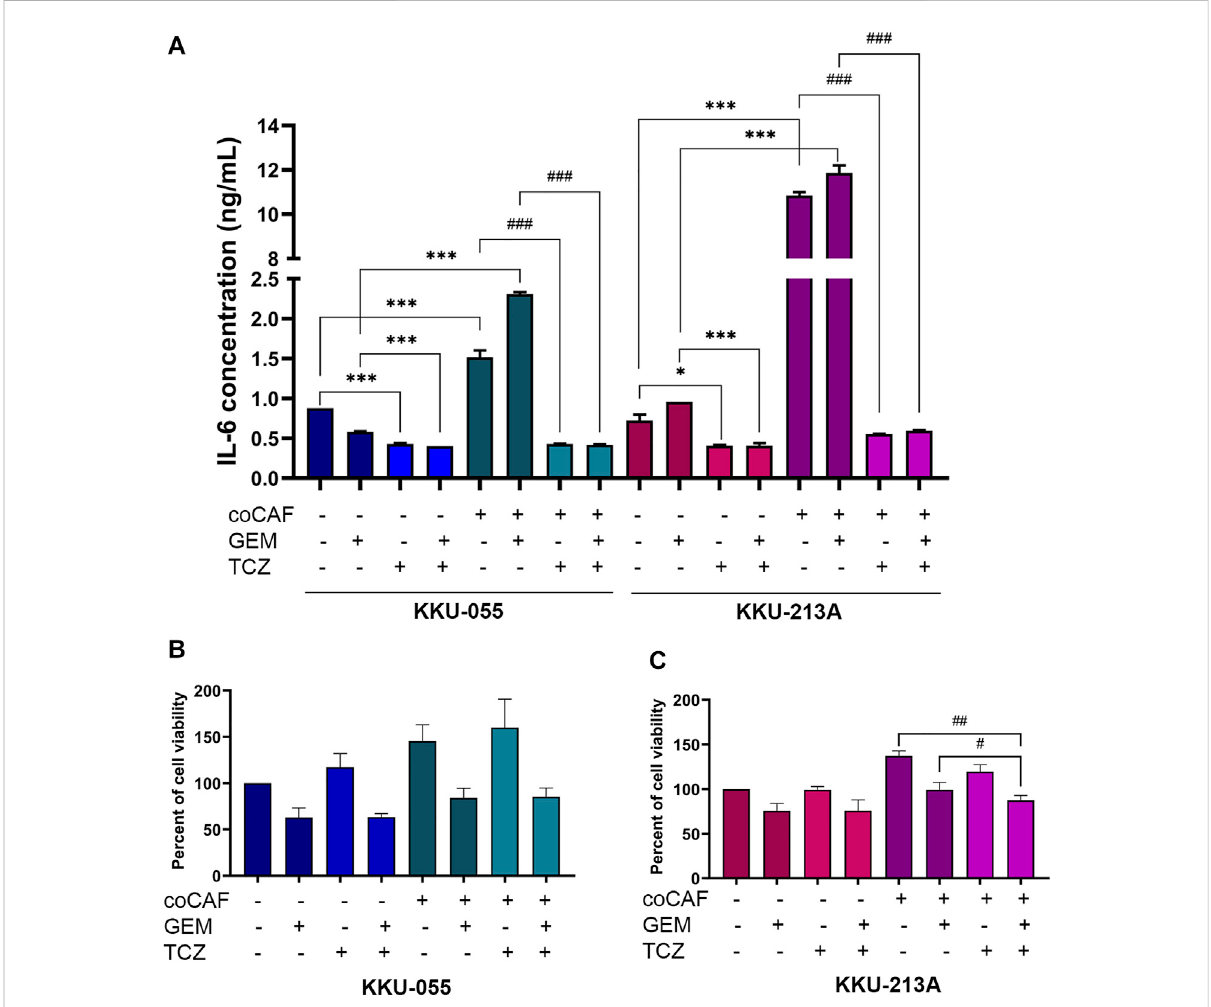
FIGURE 5 EffectofIL-6Rinhibitor(TCZ)ongemcitabineresponseofCCAcells. (A) IL-6levelsinCMsfromKKU-055andKKU-213Ainbothmono-andco- cultureweredeterminedbyhuman IL-6ELISAkit. (B,C) CCA cellviability inculturewith orwithoutCAFs andafter(ornotafter)gemcitabine andTCZ treatment was determined by MTT assay. TCZ; Tocilizumab. Error bars represent the standard deviation (SD) of triplicate experiments. A signi fi cant differencewasdeterminedusingANOVAandunpairedt-test(* p < 0.05,*** p < 0.001comparedtothosemonoculturedgroups, # p < 0.05, ## p < 0.01, ### p < 0.001 compared to co-cultured